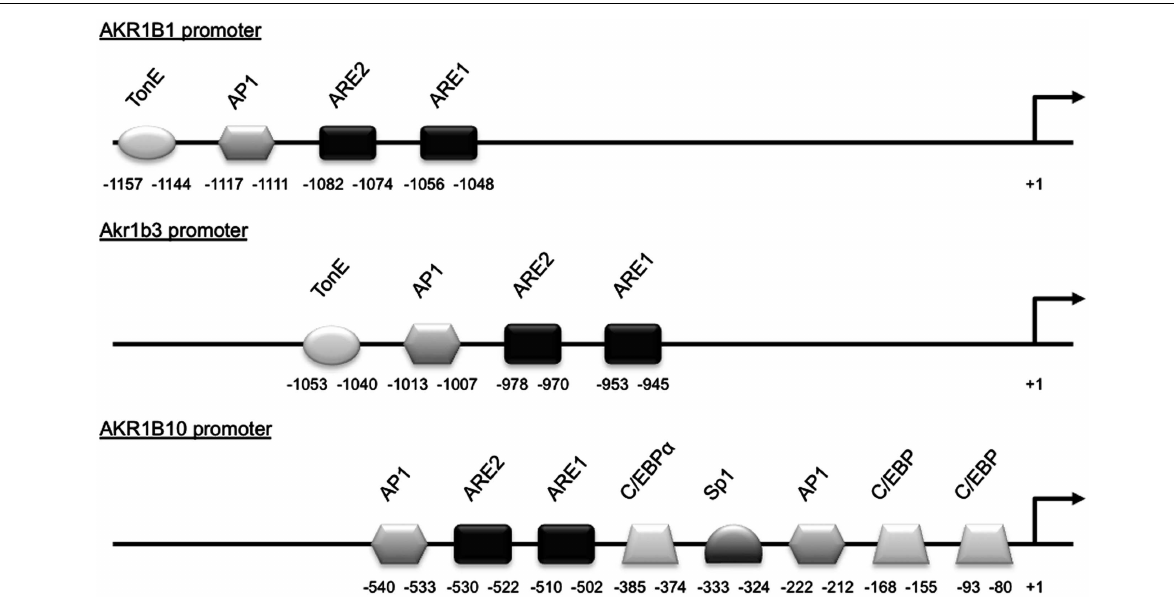
FIGURE 3 | Schematic representation of the AKR1B1 , Akr1b3 , and AKR1B10 promoters. Cis - and trans -acting factors shown to be involved in stress responsiveness are indicated.TonE, tonicity response element; AP1,